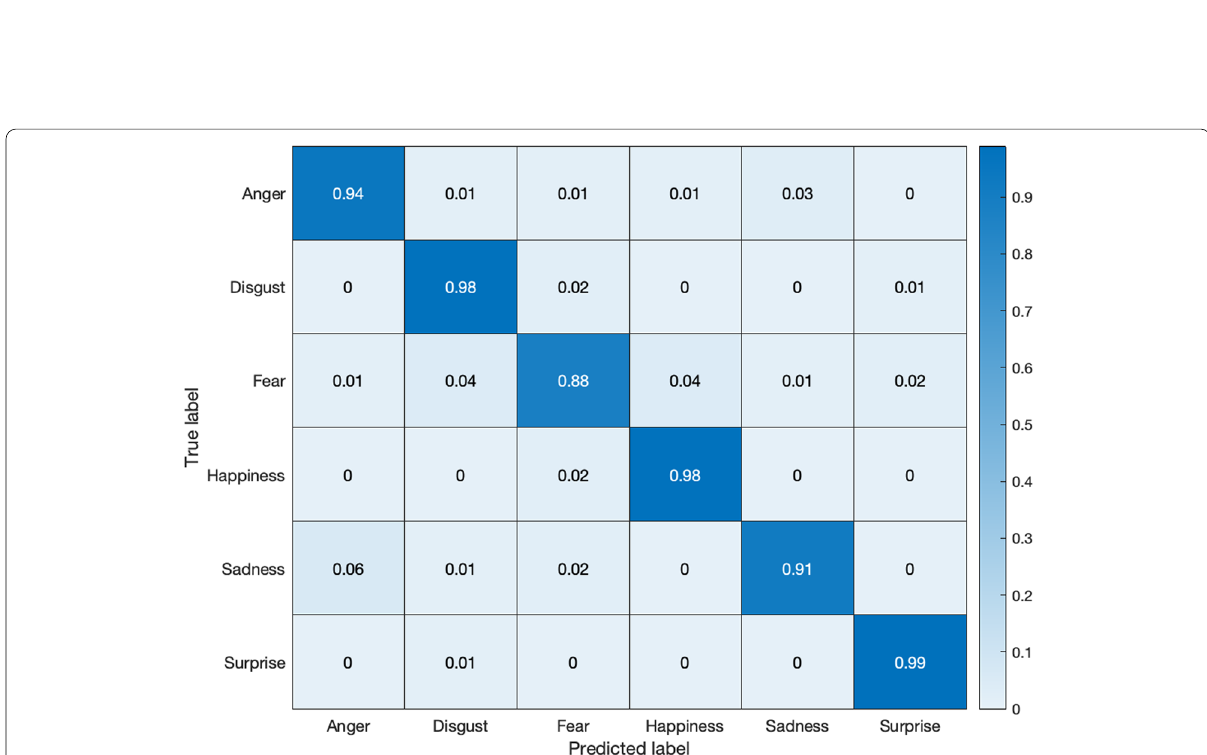
Fig. 13 Confusion matrix of facial expressions in BU3DFE